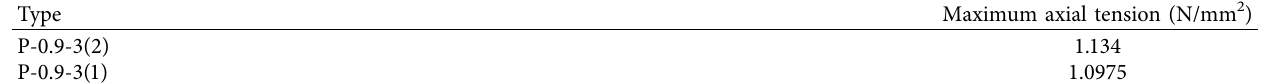
Figure 10: The comparison of the bending test results between fire-resistance polyurethane foam panels and C-0.9-3 type of foamed concrete panel. Table 8: The axial test results for two fire-resistance polyurethane foam panels.